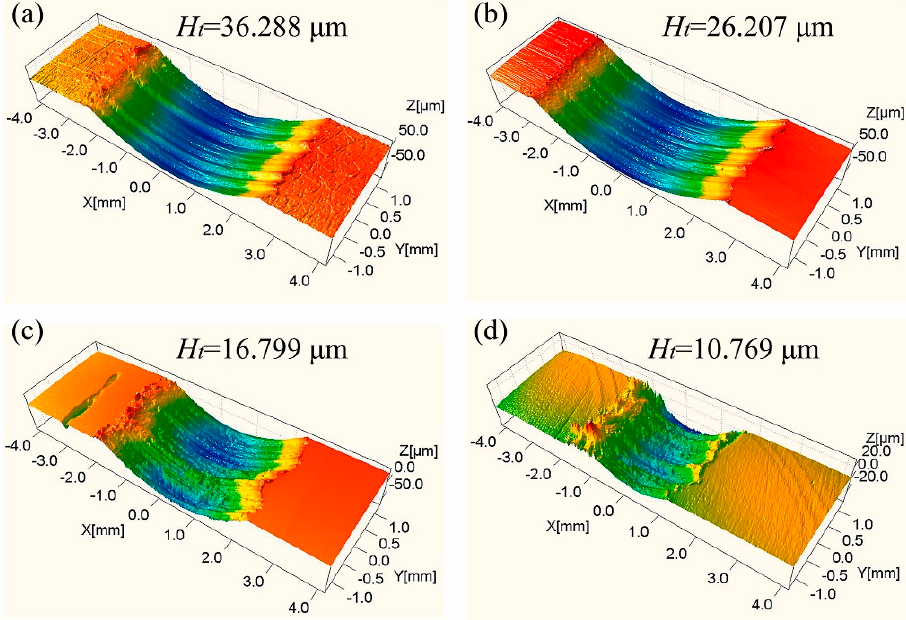
Figure 15. 3D profiles of the wear track in the CoCrAlYTa coatings with ( a ) 0%, ( b ) 1%, ( c ) 2%, and ( d ) 4% Al 2 O 3 (Reproduced from [23] with permission from Elsevier). ( d ) 4% Al 2 O 3 (Reproduced from [23] with permission from